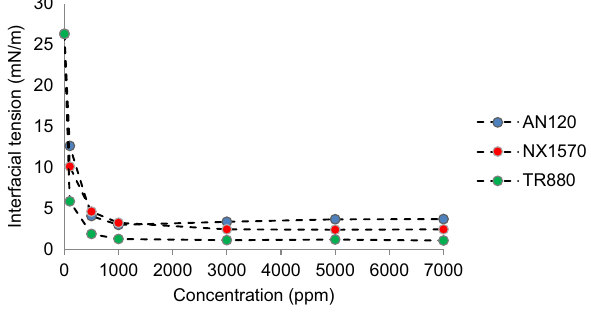
Fig. 5 Interfacial tension curves of surfactant solutions at different concentrations with formation water base and crude oil at 351.15 K and pressure of 14.7 psi